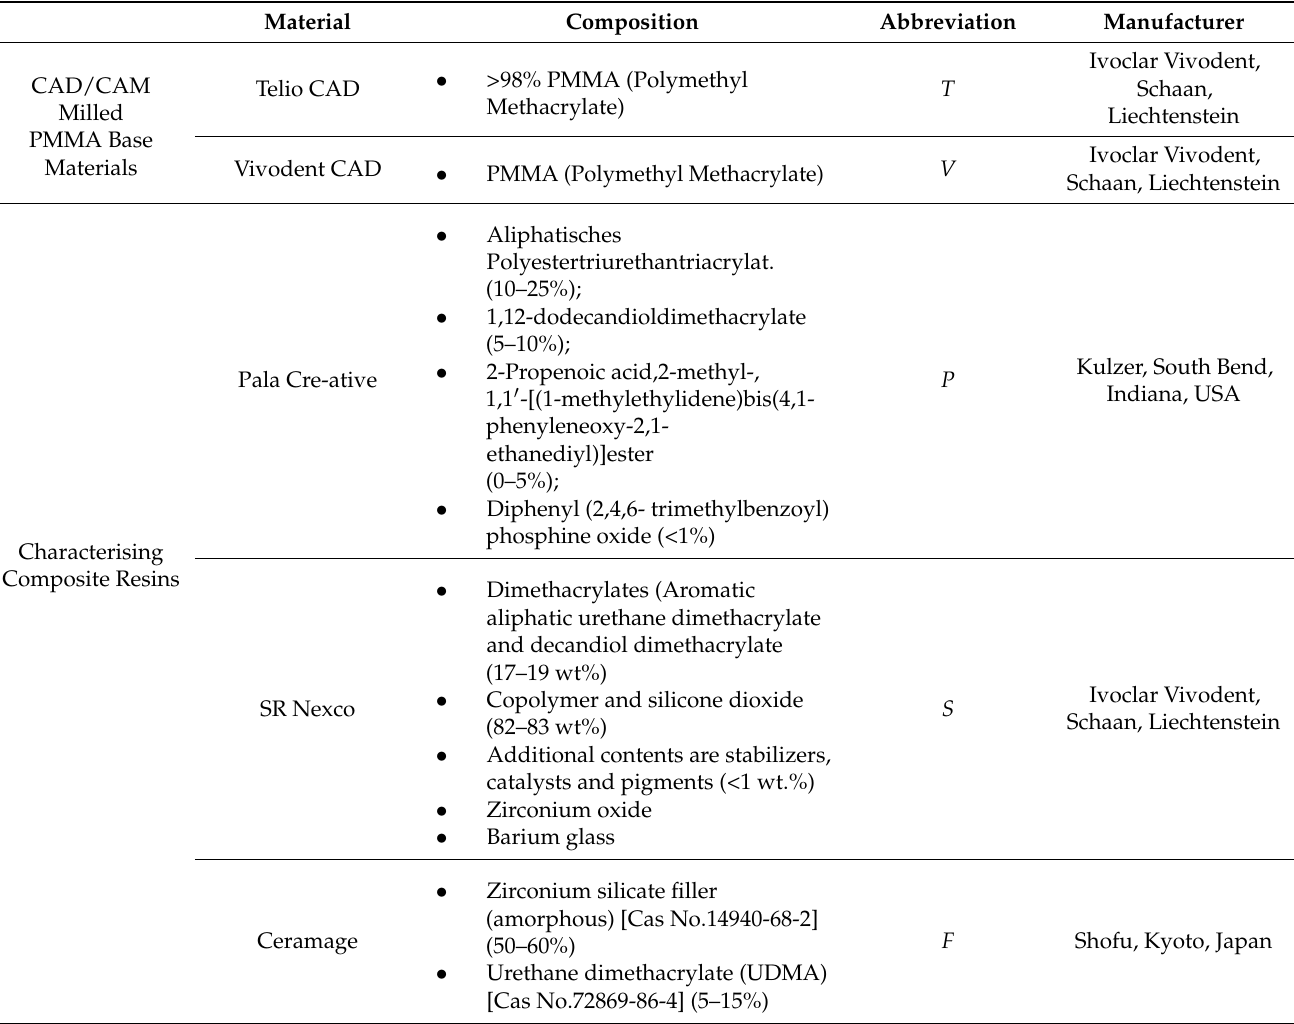
Table 1. Materials used in this study, abbreviations for each material and its